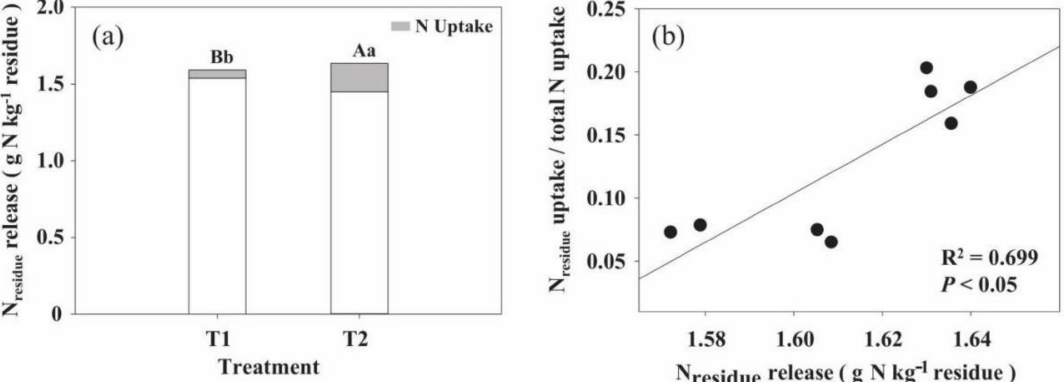
Figure 6. ( a ) Maize residue-derived N release; therein, the grey part is residue-derived N uptake by the plants. ( b ) The relationships between N residue uptake/total N uptake and N release derived from maize residue at the end of stage in the pot experiment. Mean value ( n = 4) is shown. Different upper-case letters indicate statistically significant differences at p < 0.05 in the residue-derived N release. Different lower-case letters indicate statistically significant differences at p < 0.05 in the residue-derived N